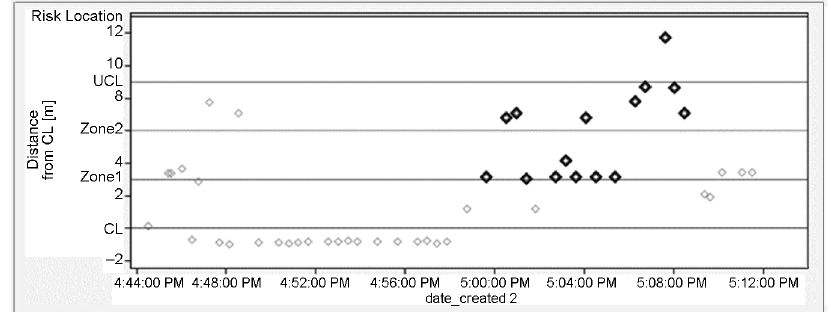
Fig. 5. Statistical alerts ensure that no unsafe situations occur despite inaccurate tracking